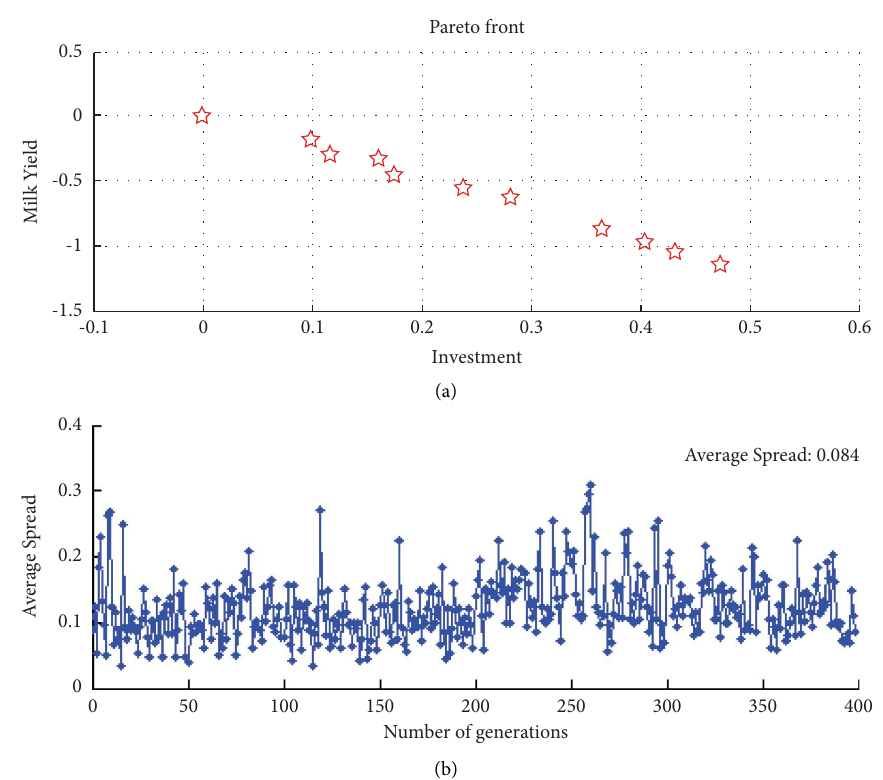
Figure 3: (a) Distribution of optimized solution set and (b) average spread with number of